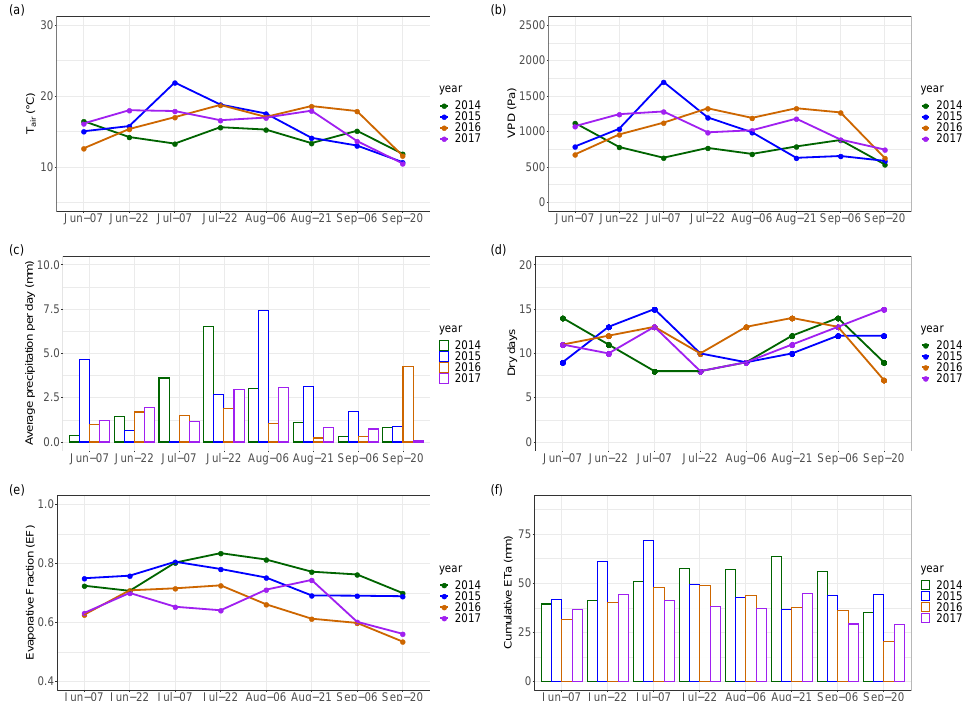
Figure 10. Micrometeorological variables on periods of 15 days. ( a ) Average air temperature ( T air ). ( b ) Average vapour pressure deficit (VPD). ( c ) Average precipitation (rain) per day (considering all days for each period). ( d ) Number of dry days. ( e ) Average evaporative fraction (EF). ( f ) Cumulative actual evapotranspiration